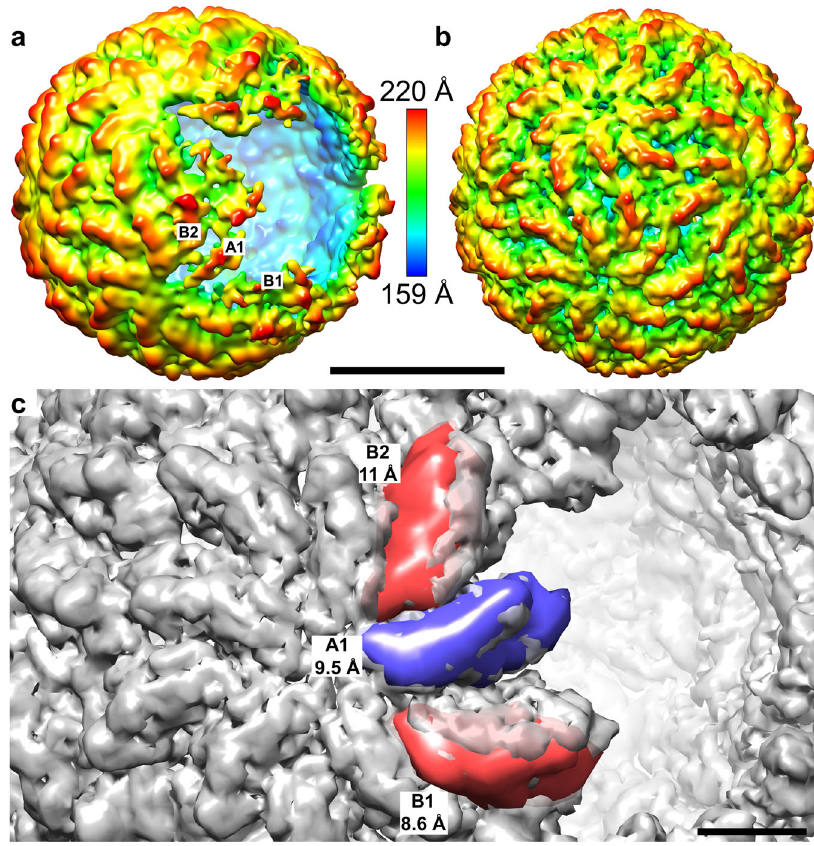
Fig. 6 The structure of L-BC open particle. a , b Cryo-EM densities of open ( a ) and complete ( b ) L-BC particles rainbow-colored according to the distance of the surface from the particle center. Selected capsid proteins bordering the opening are labeled. Scale bar 200 Å. c Displacement of capsid proteins forming the edge of the opening. The cryo-EM reconstruction of the complete particle is shown as a gray semi-transparent surface. The density of a decamer of capsid proteins was removed from the complete particle to indicate the position of the opening. The colored surfaces show positions of the three subunits that form the edge of the hole in the open particle (the A subunit is in blue, B subunits in red). The indicated distances show the relative displacements of the corresponding subunits in the complete and open particles. The displayed densities were calculated from PDB structures fi tted into the cryo-EM reconstruction of the open particle. Scale bar 50 Å. The map is contoured at 0.8 sigma for A and 2.0 sigma for B and